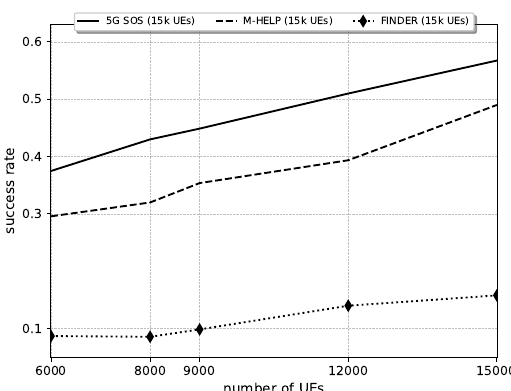
Figure 10. Comparison of successful rate against number of UEs (NoU) under 5G-SOS, M-HELP, and FINDER. Parameters: NoU: 6000 to 15,000, NEC: 5000, ETI: 1800 s (30